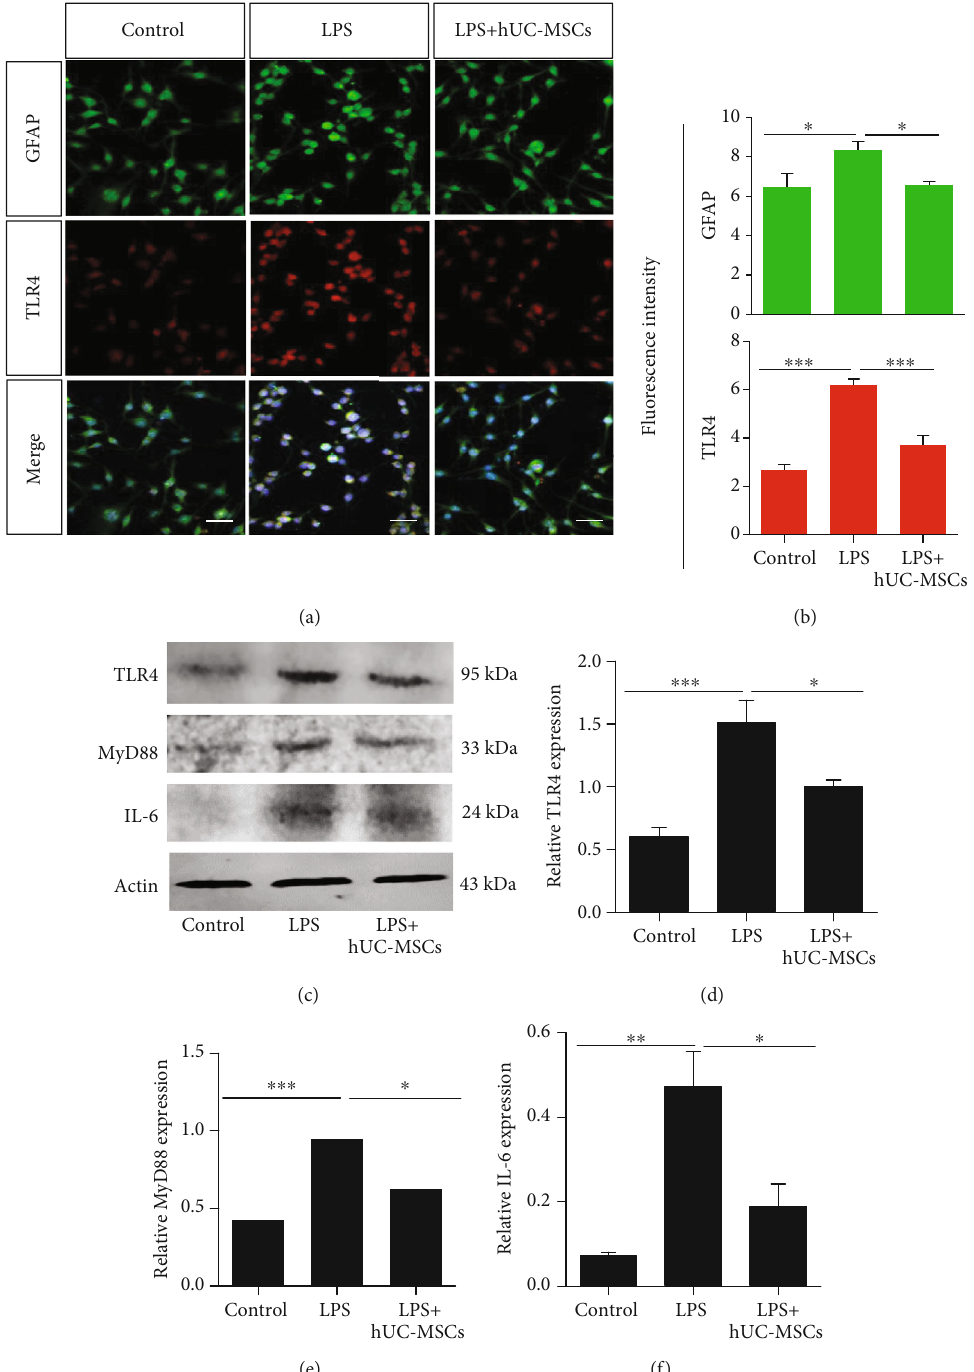
Figure 7: hUC-MSCs modulate TLR4 pathway-related agents and proin fl ammatory mediator levels in LPS-treated rMC-1 cells. (a and b) Double staining for GFAP (green) and TLR4 (red) showing colocalization of GFAP and TLR4. The fl uorescence intensity showing reduced expression of GFAP and TLR4 in LPS-treated rMC-1 cells after hUC-MSC treatment ( n = 4/group ; ∗ P < 0 : 05 and ∗∗∗ P < 0 : 001 compared with one-way ANOVA with Turkey ’ s post hoc tests). (c and d) Quanti fi cation of TLR4, MyD88, and IL-6 expression by western blot analysis showing a signi fi cant decrease in TLR4, MyD88, and IL-6 expression after hUC-MSC treatment ( n = 4/group ; ∗ P < 0 : 05 , ∗∗ P < 0 : 01 , and ∗∗∗ P < 0 : 001 compared with one-way ANOVA with Turkey ’ s post hoc tests). Scale bar: 50 μ